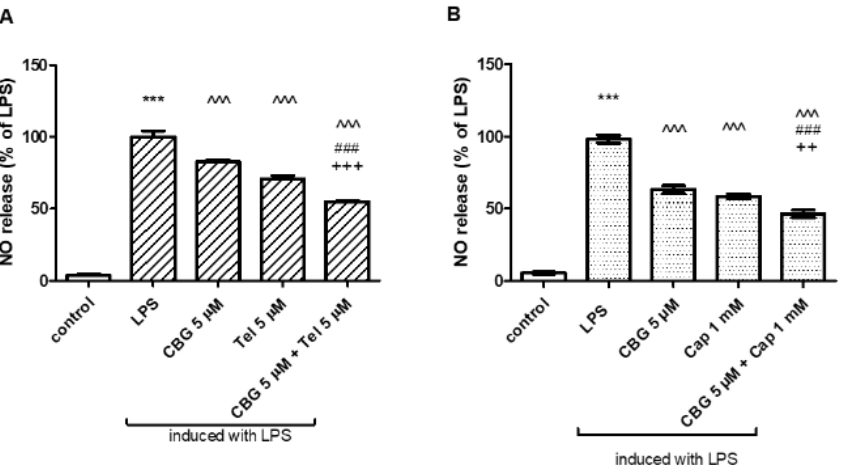
Figure 3. CBG in combination with telmisartan ( A ) but not captopril ( B ) additively decreased NO production in LPS-induced BV2 microglia. Cells were pre-incubated with SFM for 4 h and then incubated for 22 h with 7 ng/mL LPS in the presence of the specific compounds. Culture media were analyzed for NO levels and normalized to cell counts. Means ± SEM of representatives of two–three independent experiments are presented (n = 6). One-way ANOVA and a Tukey–Kramer multiple comparison test were performed for statistical significance. *** p < 0.001 vs. control; ˆˆˆ p < 0.001 vs. LPS; ### p < 0.001 vs. CBG; +++ p < 0.001 vs. Tel; ++ p < 0.005 vs. Cap.